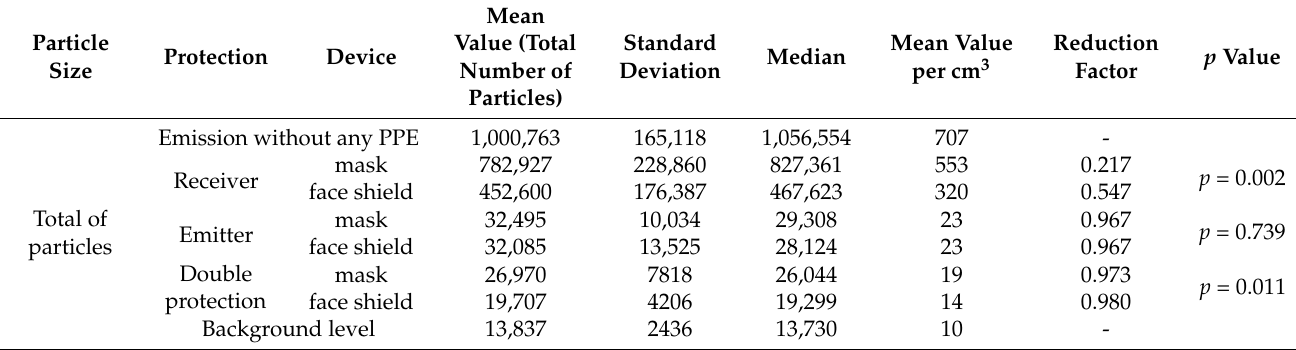
Table 1. Reduction factor (RF) and Percentage of Total Inhaled Particles (PTIP) in the different configurations.